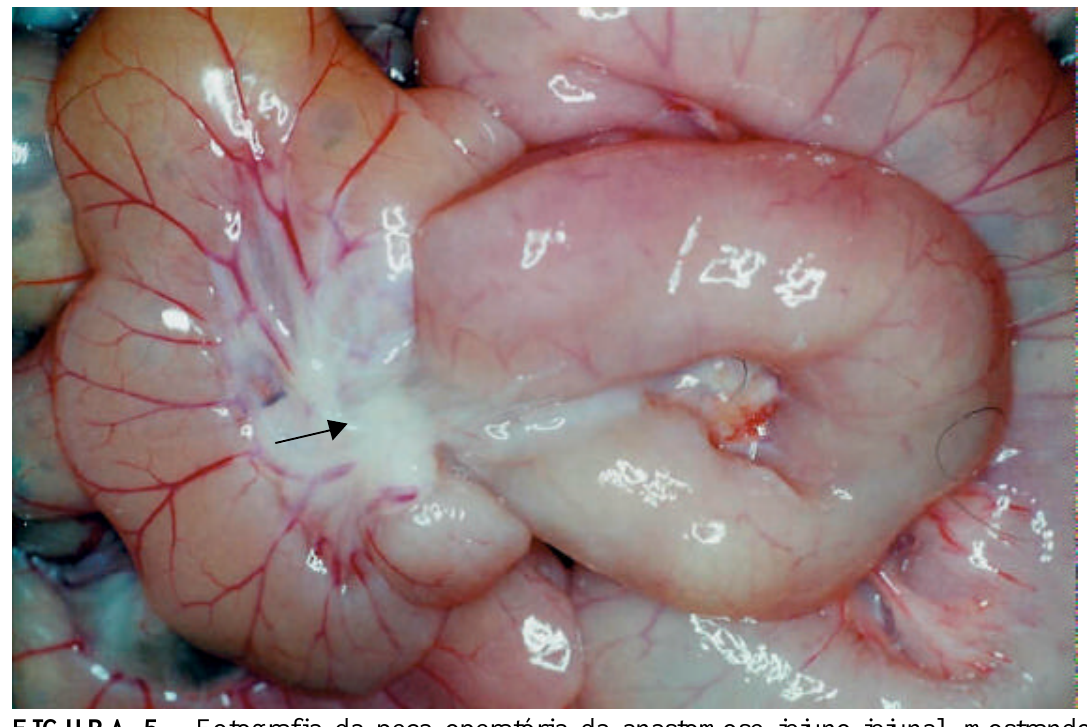
FIGURA 5 – Fotografia da peça operatória da anastomose jejuno-jejunal, mostrando a aderência na linha de cicatrização (seta), sub-grupo Af (adesivo biológico – 2 pontos) no 14º dia de